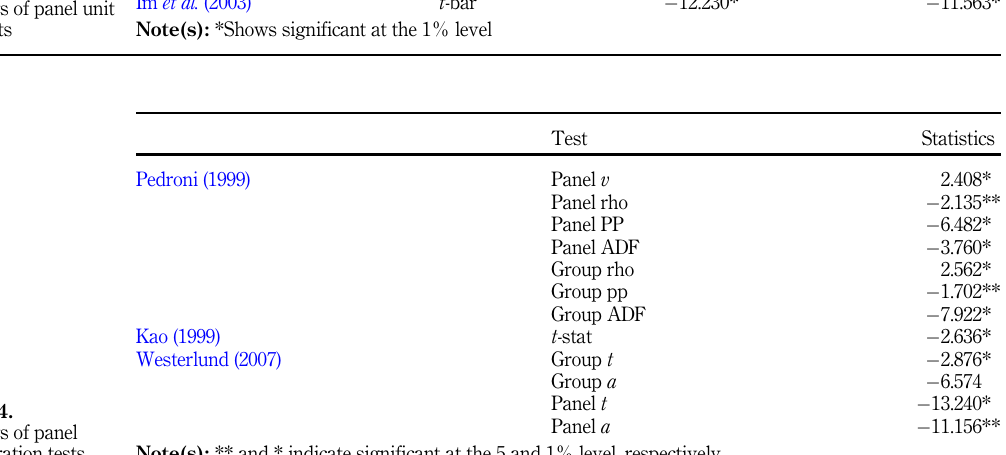
Table 3. Findings of panel unit root tests